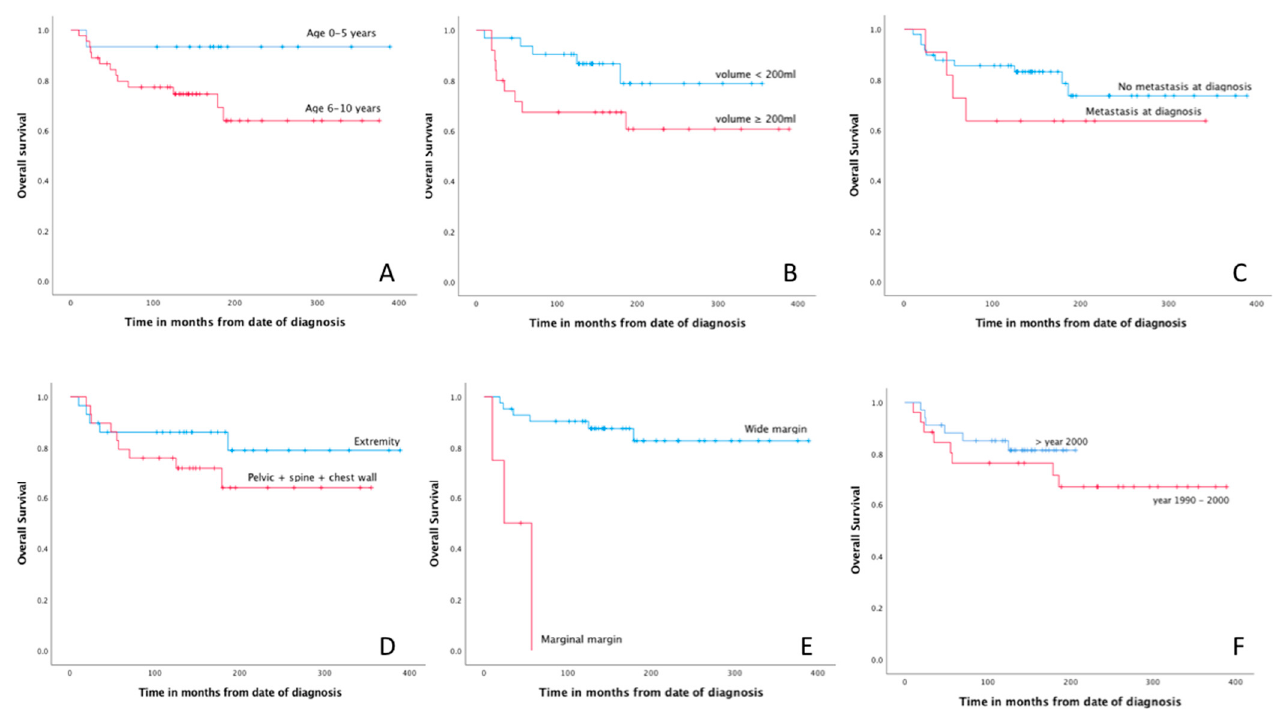
Figure 1. Kaplan–Meier curves for age ( A ), tumor volume ( B ), metastasis at diagnosis ( C ), tumor location ( D ), surgical margin ( E ) and treatment era ( F